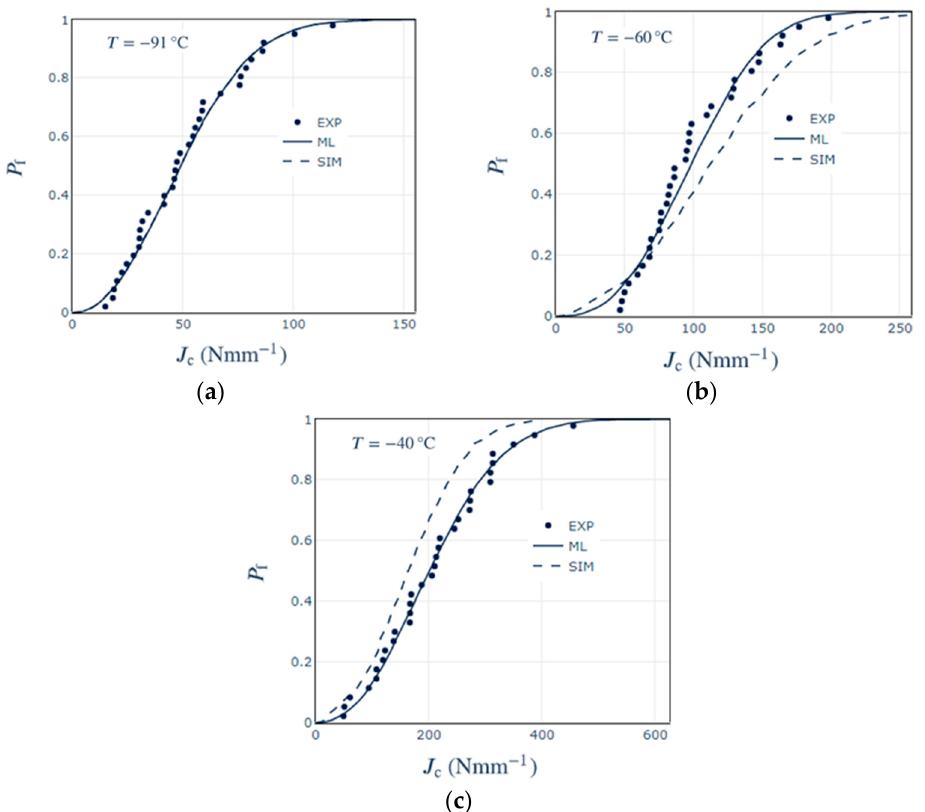
Figure 6. Cumulative probability function of experimentally measured J c using the Maximum Likelihood (ML) method and Weibull fit as predicted by the proposed method for ( a ) T = − 91 ◦ C, ( b ) T = − 60 ◦ C and ( c ) T = − 40 ◦ C, where the toughness data at T = − 91 ◦ C is used for calibration of the model at m = 7.